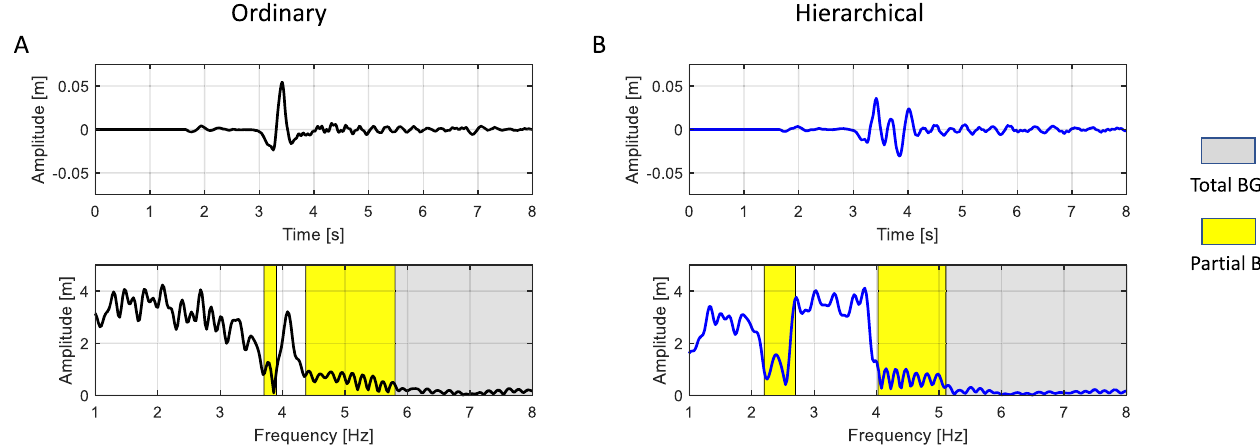
Fig. 4. Time histories and Fourier transform. Out-of-plane time transient displacement and its Fourier transform for the broad- band excitation for both the ordinary (A, black line) and hierarchical (B, blue line) structures. The signals are acquired immediately after the end of the periodic structure. The Fourier transforms of the signals allow to show the difference of the two responses in terms of frequency content, showing the ability of the hierarchical unit cell to provide large attenuation in the [2.2 (cid:1) 2.7] Hz frequency range and above 5.1Hz, in good agreement with the dispersion diagrams reported in Figure 3B and E. BGs calculated in Figure 3B and E are superimposed onto each frequency response, to visually highlight how the frequency responses matches the dispersion